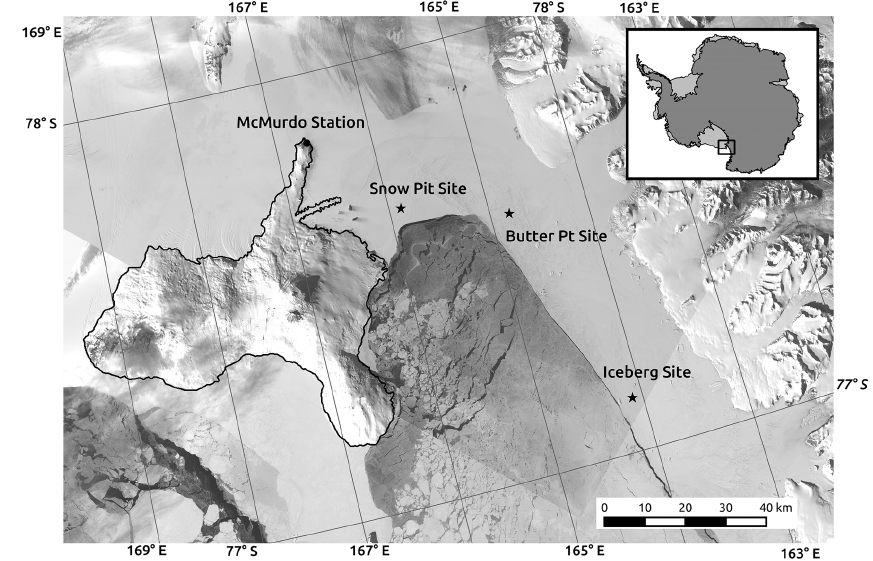
Figure 1. Map of the Ross Sea region showing the two field sites Butter Point and Iceberg. Basemap is Landsat